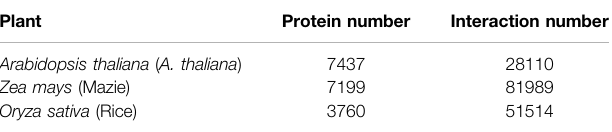
TABLE 7 | Number of entries of the three different plant PPI datasets. Plant Protein